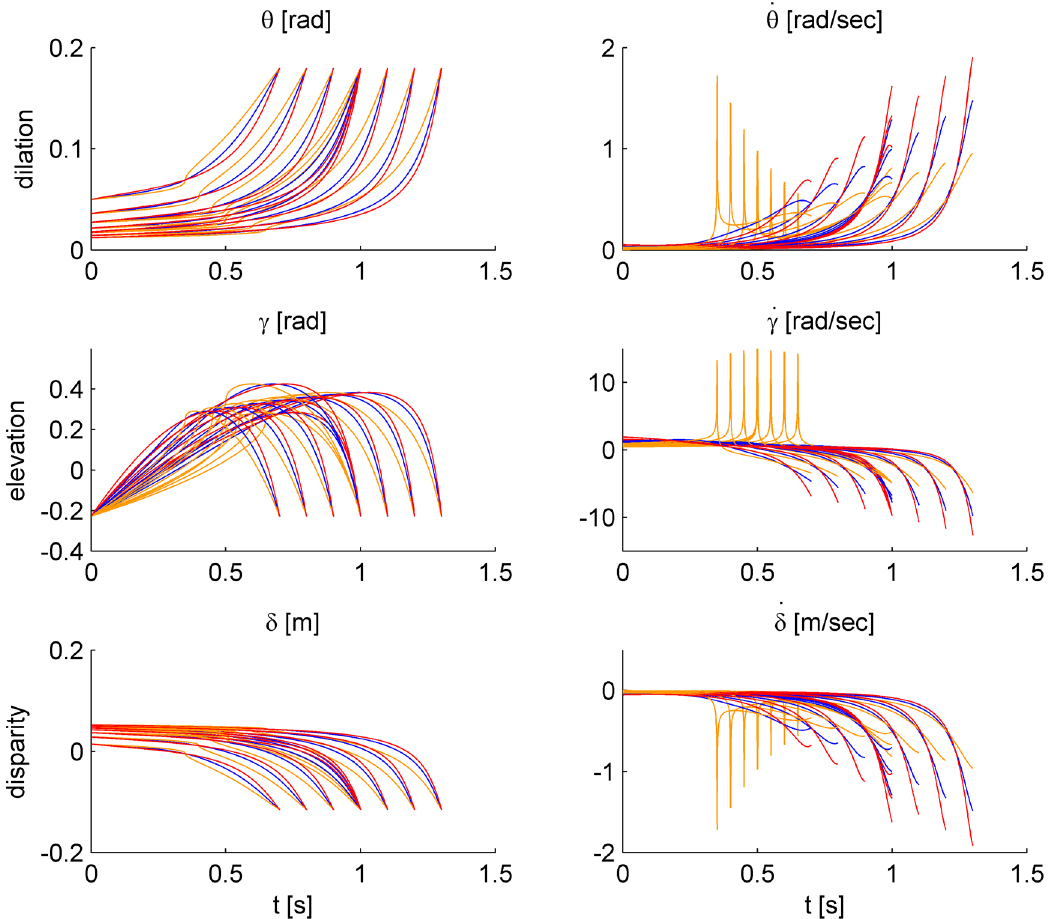
Figure 3. Time course of changes of dilation (retinal image expansion), dilation rate, elevation angle, elevation angle rate, disparity and changing disparity of the stimuli for conditions #1-#9. Blue, orange and red curves correspond to constant tangential velocity, constant vertical velocity, and gravitational acceleration,